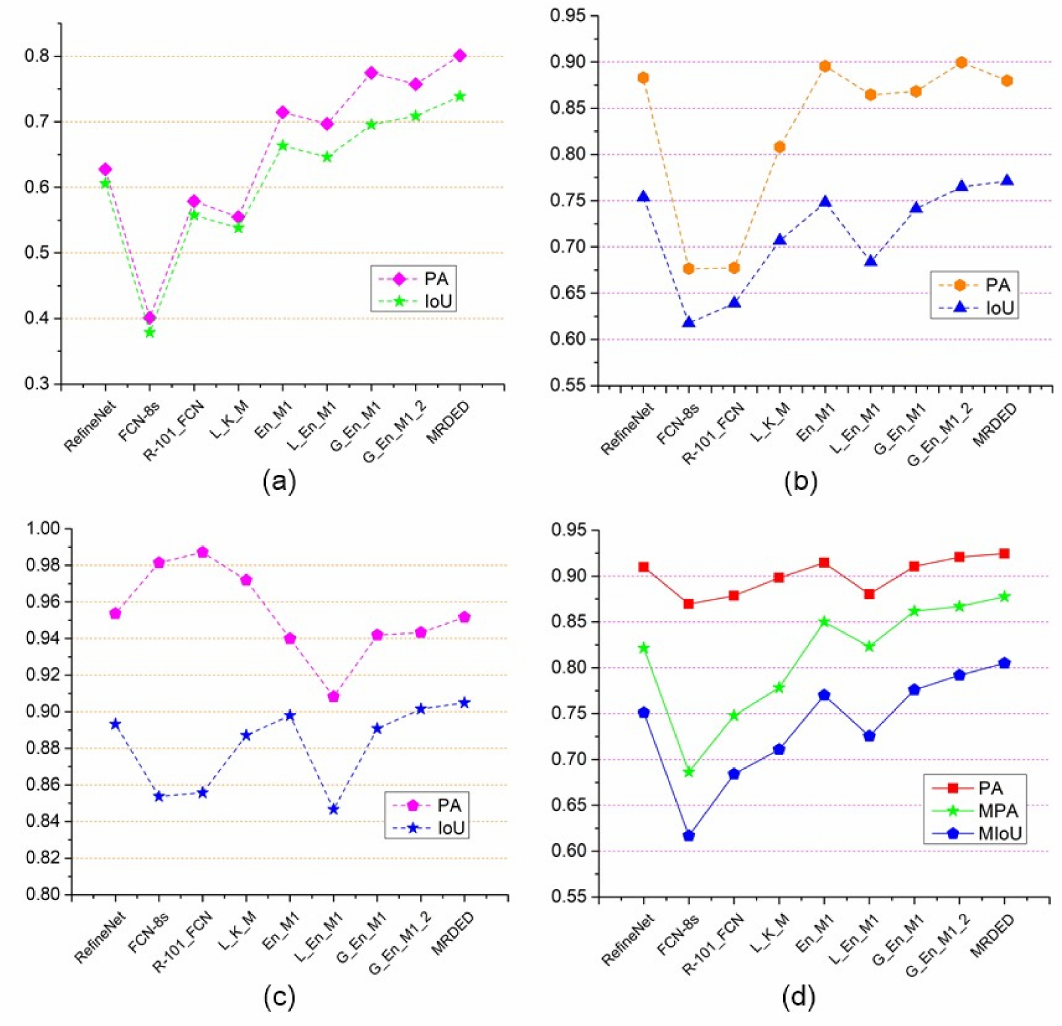
Figure 13. The accuracies for di ff erent types of targets with di ff erent frameworks. ( a ) The classification accuracy for water with di ff erent frameworks. ( b ) The classification accuracy for shadow with di ff erent frameworks. ( c ) The classification accuracy for background with di ff erent frameworks. ( d ) The overall accuracy for the three